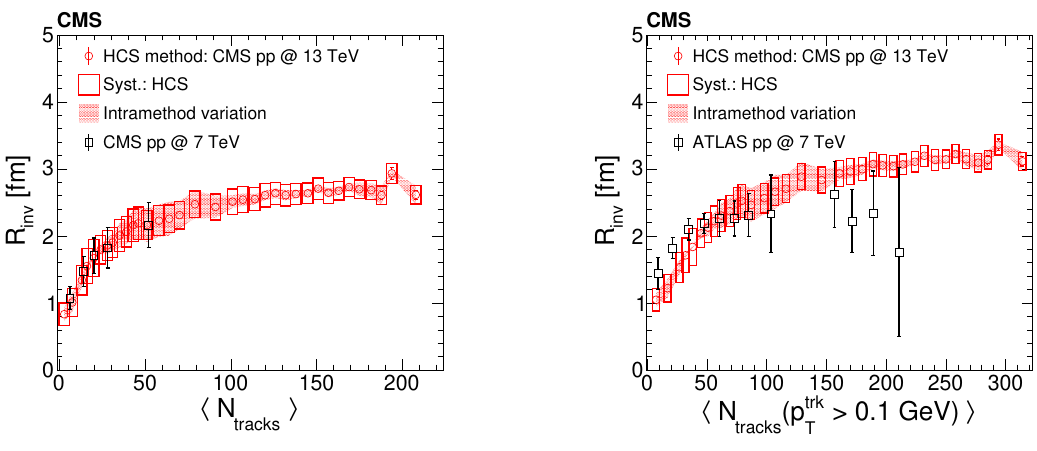
Figure 5 . The R (cid:12)t parameters as a function of particle-level multiplicities using the HCS inv method in pp collisions at 13 TeV compared to results for pp collisions at 7 TeV from CMS (left) and ATLAS (right). Both the ordinate and abscissa for the CMS data in the right plot have been adjusted for compatibility with the ATLAS analysis procedure, as explained in the text. The error bars in the CMS [5] case represent systematic uncertainties (statistical uncertainties are smaller than the marker size) and in the ATLAS [15] case, statistical and systematic uncertainties added in